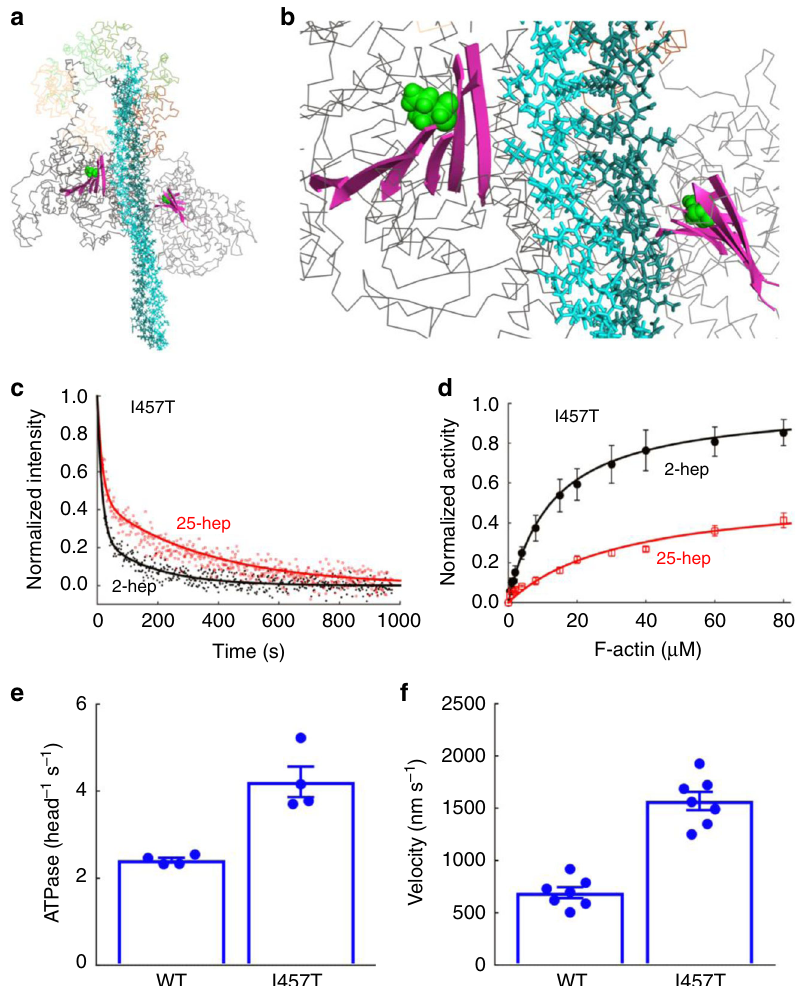
Fig. 7 Effect of I457T mutation on HMM ATPase kinetics and in vitro motility velocity. The I457T mutation (green spheres) shown on the MS03 homology model 26 of the IHM. The mutation is located on the transducer region (pink ribbons) and is not close to the proposed interfaces within the IHM. b Close up of transducer region from panel a . c Mant-nucleotide release kinetics for I457T 2-hep and 25-hep HMM. d Actin-activated ATPase activity of I457T 2-hep and 25-hep HMM. e Bar plot showing the actin-activated ATPase activity of WT and I457T 2-hep HMM. f Bar plot showing the actin gliding velocity as measured by the in vitro motility assay of WT and I457T 2-hep HMM. In panels e andand f individual data points are denoted by closed circles. c Shows representative data from one preparation of each protein. Panel d is combined data from two independent protein preparations with three experimental replicates for each preparation. For panels e and f , each point is an average of two independent experiments (each from a different myosin preparation). Error bars represent the SEM. Source data are provided as a Source Data fi linker, eGFP, a second GSG linker, and fi nally an eight amino acid peptide (RGSIDTWV) to facilitate surface attachment via an engineered PDZ protein (see Supplementary Methods for more detail) 19 . These constructs containing the HCM mutations (mutagenic primer sequences provided in Supplementary Methods) were co-expressed with FLAG-tagged human ELC in differentiated mouse myoblast C2C12 cells (ATCC) using adenovirus vectors. After harvesting and lysing the C2C12 cells, the HMM was fi rst bound to a FLAG-af fi nity resin. Then the endogenous mouse skeletal RLC, which was bound to the human cardiac HMM, was exchanged with human cardiac RLC as described in Supplementary Methods 25 . The fully assembled 2-hep and 25-hep HMMs were then puri fi ed using FLAG-af fi nity and anion-exchange chromatography. Actin from bovine cardiac ventricle was a generous gift from Myokardia Inc., and was cycled through two rounds of depolymerization – repolymerization prior to use 46 . To form F-Actin for actin-activated ATPase assays, the actin was extensively dialyzed in ATPase buffer (10 mM imidazole, pH 7.5, 5mM KCl, 1mM DTT, and 3mM MgCl 2 ). Mant-ATP single turnover . Single turnover experiments were performed in a fl uorescence plate reader (Tecan model – In fi nite M200 PRO). Experiments were performed with the WT and mutant versions of human β -cardiac 25-hep HMM and 2-hep HMM in a 96-well plate (Greiner polypropylene microplate) by mixing 100 nM myosin in a buffer containing 10 mM Tris pH 7.5, 4 mM MgCl 2 , 1 mM